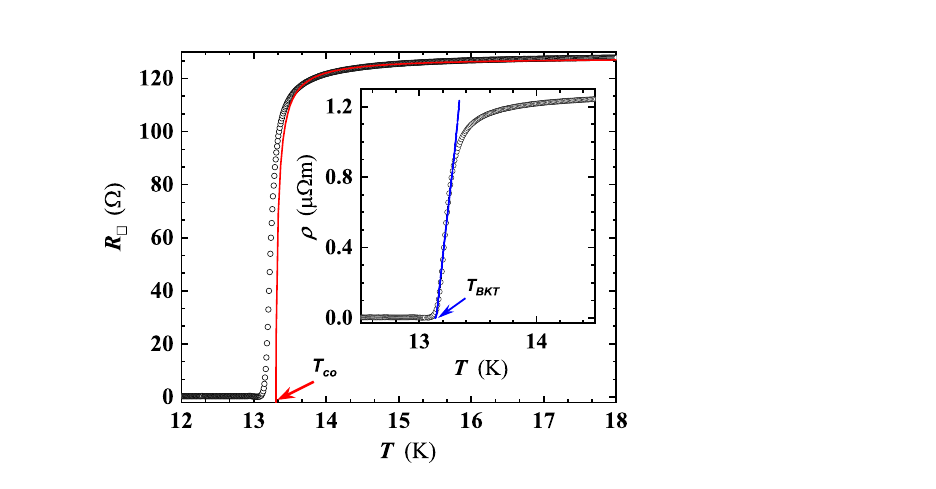
Figure 6. Temperature − dependent sheet resistance around the superconducting transition tempera- ture for MO10 (see Table 2). The red line is the least-squares fit by using Equation (1). The value of T c 0 = 13.31 K (red arrow) is the intercept of the red line with the x -axis. Inset: least-squares fitting of the ρ ( T ) curve of MO10 by Equation (2). The intercept with the x -axis gives the value of T BKT (13.06 K, blue arrow). Table 2. Berezinskii–Kosterlitz–Thouless (BKT) parameters derived by the analysis of the resistivity and I-V characteristics curves of some of the thinner NbN films. Column headings, from left: sample acronym *; BKT temperature derived by ρ ( T ) fitting with Equation (2); SC transition temperature at B = 0 (see the text); normal state sheet resistance at 20 K; γ value (see the text and Equation (1)); VAP